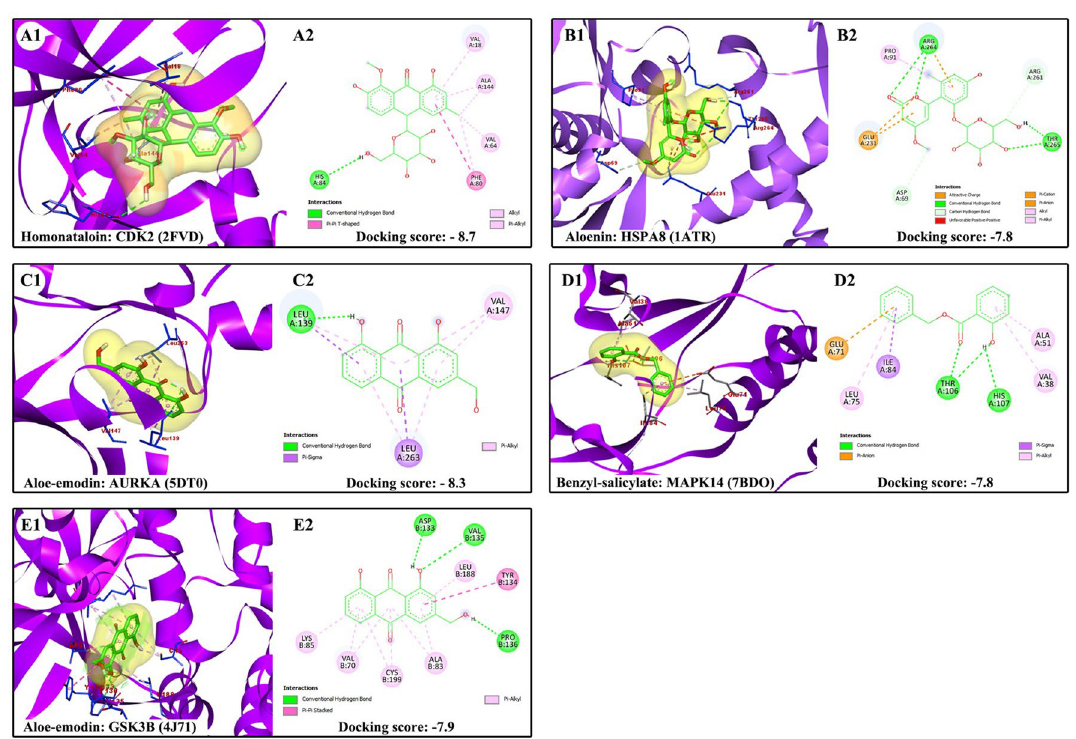
Figure 7. Molecular docking analysis of selected phytochemicals and targets. ( A 1- E 1) 3D pose views of interaction selected phytochemicals and targets. ( A 2- E 2) 2D pose views of interaction of selected phytochemicals and